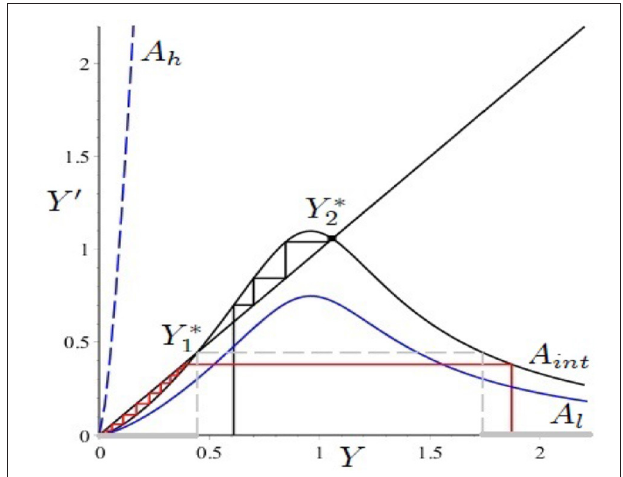
FIGURE 8 | Figure reproduced with the permission of the publisher. Source: Caravaggio and Sodini [ 14]. Parameter set: α = 0.6, β = 0.4, γ = 0.4, δ = 0.1, θ = 1.12, λ = 8.92, ρ = 0.1, σ = 0.2, τ = 0.21, φ = 0.19, E = 0.000001, A h = 5,000, A int = 250, A l = 150. For A = A int , the map admits three stationary equilibria: 0 (stable), Y ⋆ 1 = 0.444 (unstable) and Y ⋆ 2 = 1.057 (stable). The basin of 0 is nonconnected and consists of two parts: the immediate basin in (0, Y * 1 ) and the other part ( Y p , +∞ ), where Y p is the preimage of Y * 1 . On the contrary, the basin of Y * 2 is connected being a single interval ( Y * 1 , Y p ).